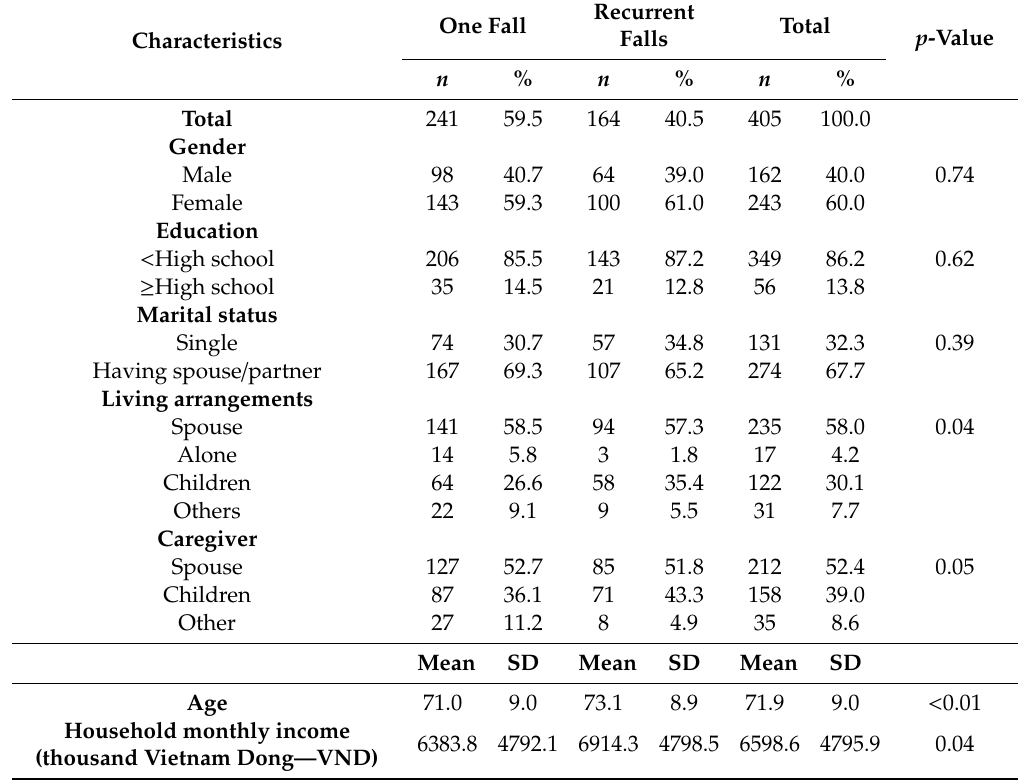
Table 1. Sociodemographic and behavior characteristics of